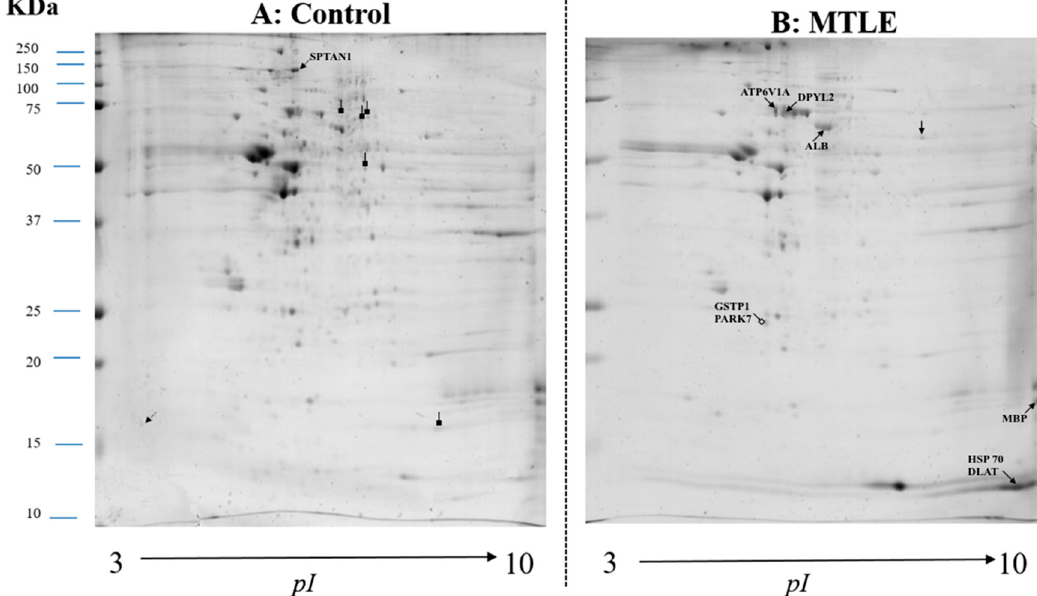
Figure 1. A representative 2D-PAGE image showing all 16 spots of protein of interest from control ( n = 10) ( A ) and patients with mesial temporal lobe epilepsy (MTLE) ( n = 6) ( B ). ( A ) Arrows with black square tips are the proteins detected only in the control group (5) which were not satisfactorily identified. Up-regulated proteins are shown as dotted arrows (2), one of which was identified as the spectrin alpha chain (SPTAN1). ( B ) Arrows with empty square tips are the proteins detected only in MTLE patients (2) identified as glutathione S-transferase P (GSTP1) and protein DJ-1 (PARK7). Up-regulated proteins are shown as filled arrows (7) identified as proton ATPase catalytic subunit A (ATP6V1A), heat shock protein 70 (HSP70), dihydropyrimidinase-related protein 2 (DPYSL2), isoform 1 of myelin basic protein (MBP) isoform 1 of serum albumin (ALB), heat shock protein 70 (HSP70), and dihydrolipoamide S-acethyltransferase (DLAT).